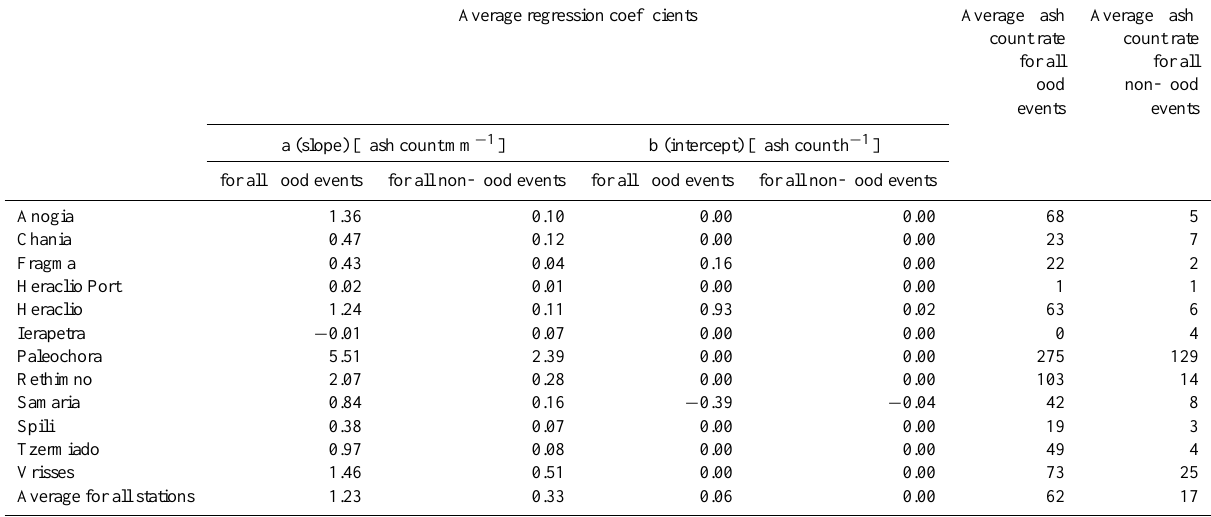
Table 3. Average coefficients, slope (a) and intercept (b) of linear regression ( y = a · x + b ) and average flash count rate for all flood and non-flood events for each